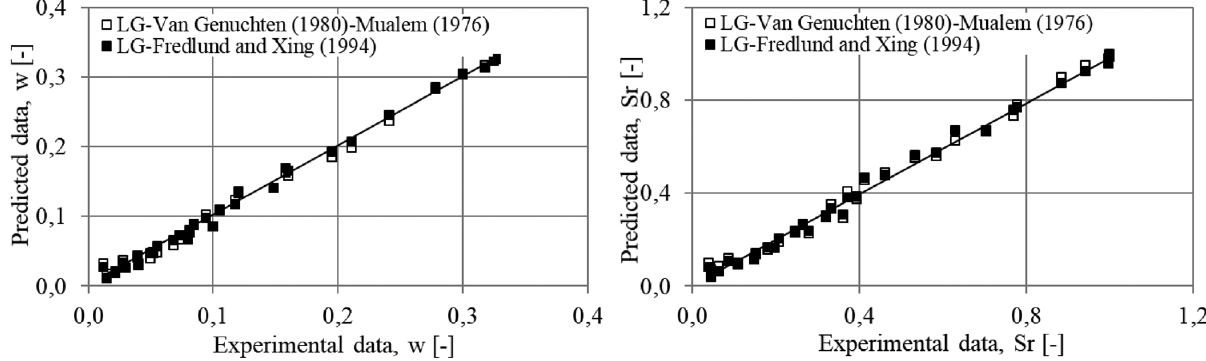
Figure 12: Veri fi cation of experimental with predicted data of SWCC: ( left ) gravimetric water content ( w ) results and ( right ) degree of saturation ( Sr ) results for LG